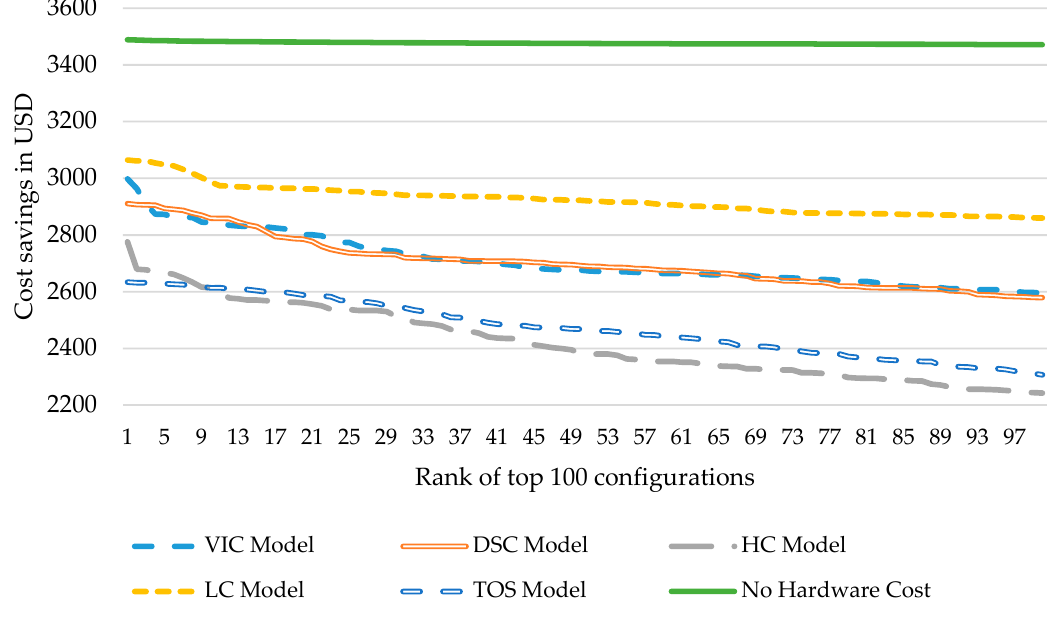
Figure 10. Cost savings of the best 100 configurations for the four different categories.